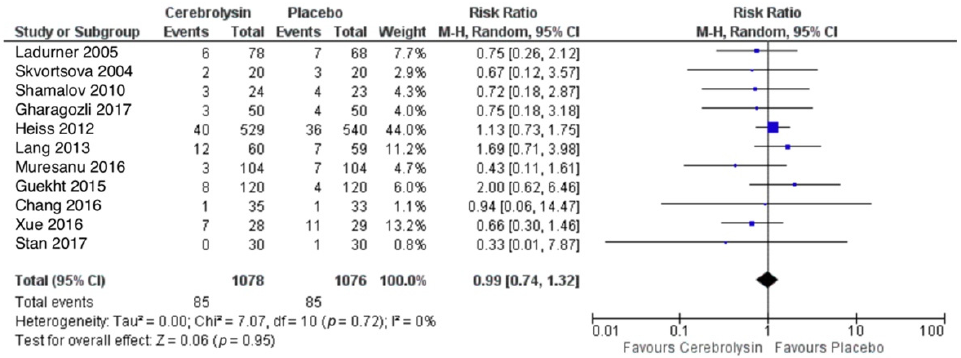
Figure 3. Serious adverse events (patients with at least one SAE); Comparison of Cerebrolysin versus Placebo in the Safety Population, Random Effects, M-H, Risk Ratio (RR).